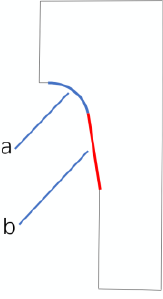
Figure 3. Key dimensions of the nosing die. a — Fillet radius of the die (R); b — Inclination angle of the die (α). (Unit: mm).